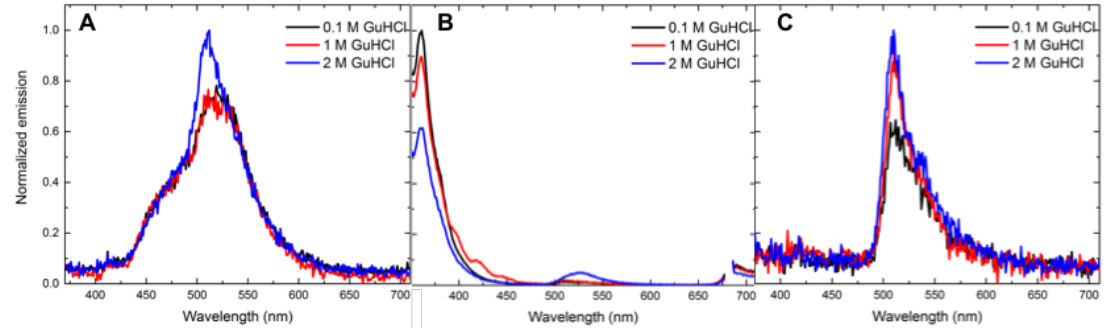
Figure 7. A comparison of the fluorescence emission in γ-cyclodextrin with 0.1 M GuHCl (black line), 1 M GuHCl (red line), and 2 M GuHCl (blue line) with ( A ) analyte 2 ; ( B ) analyte 4 ; and ( C ) analyte 5 with compound 7 .